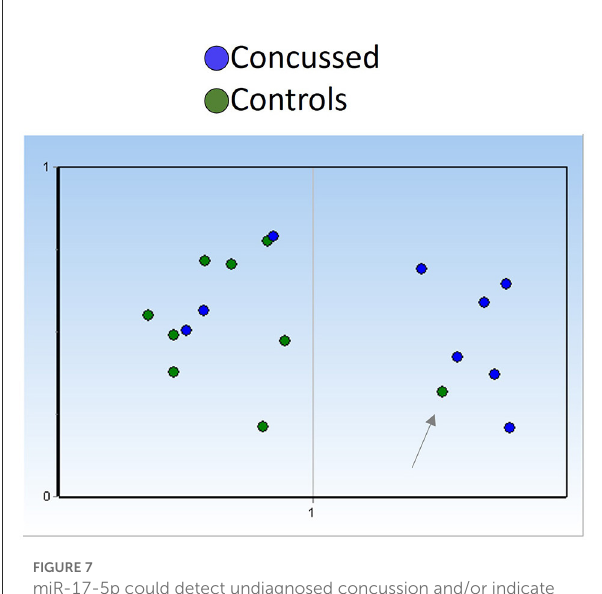
FIGURE7 miR-17-5p could detect undiagnosed concussion and/or indicate restored neuronal fitness after concussion. Unsupervised clustering (Kohonen self-organizing map) of serum samples based on miR-17-5p expression at the end of season timepoint (controls n = 9; concussed n = 9) indicates the presence of three players who had concussion (blue dots) in group 1, otherwise constituted by control players green dots, suggesting neuronal fitness recovery. The presence of one control sample (pointed by an arrow) within the group of concussed players may indicate an undiagnosed brain injury in this player. Self-organizing map (SOM) was fixed automatically at 1 ( y -axis), and number of groups are indicated in the x